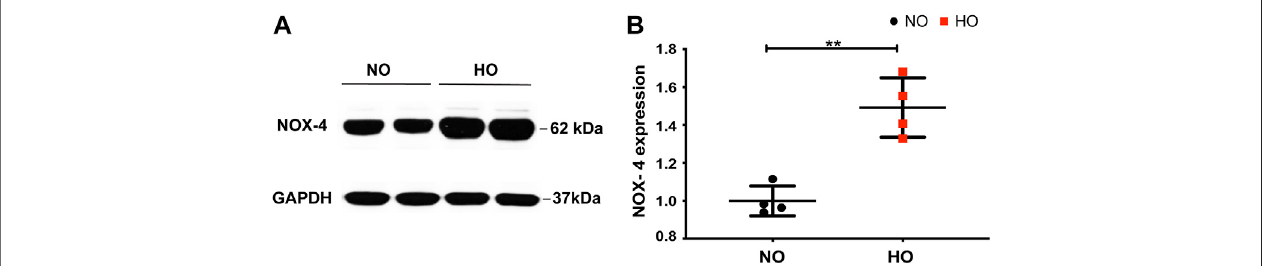
FIGURE 1 | HO induces NOX4 expression in lung tissue. To determine the role of NOX4 in HALI, wild type (WT) mice (C57BL/6J male, ~25 g body weight) were exposedtoeitherNOorHO(95%oxygen)for66 h.TotallungtissueproteinwasthensubjectedtoSDS-PAGEfollowedbyimmunoblottingwithanti-NOX4antibody. (A)